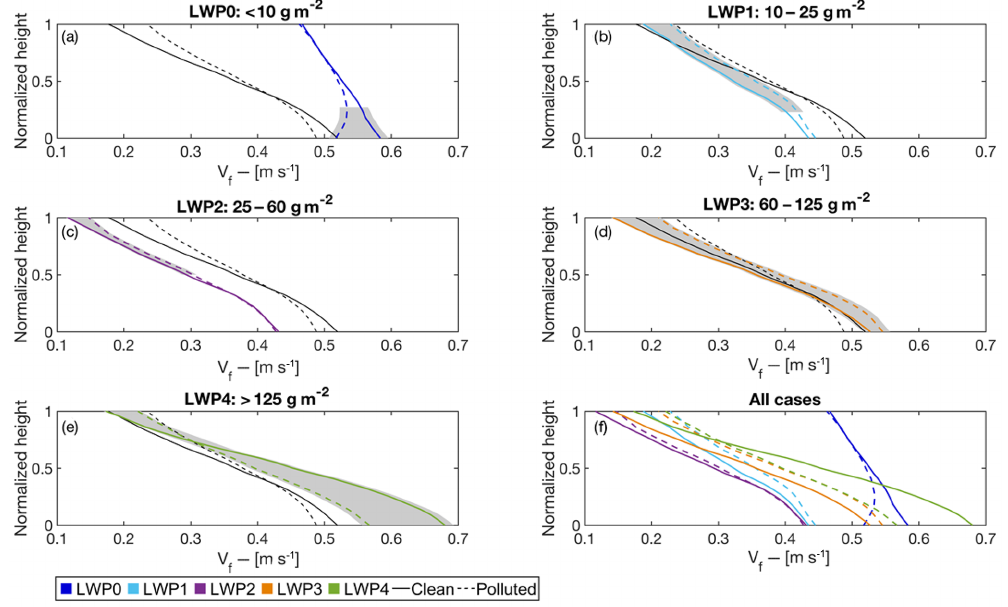
Figure 3. Vertical profiles of 120min time-averaged mean Doppler velocity for clean and polluted conditions for (a) LWP0, (b) LWP1, (c) LWP2, (d) LWP3, (e) LWP4 and (f) all LWP bins. The black reference lines in each panel represent the mean profiles for all the LWP bins. Grey shading represents regions of the cloud layer where there is a statistically significant difference between the clean and polluted V f